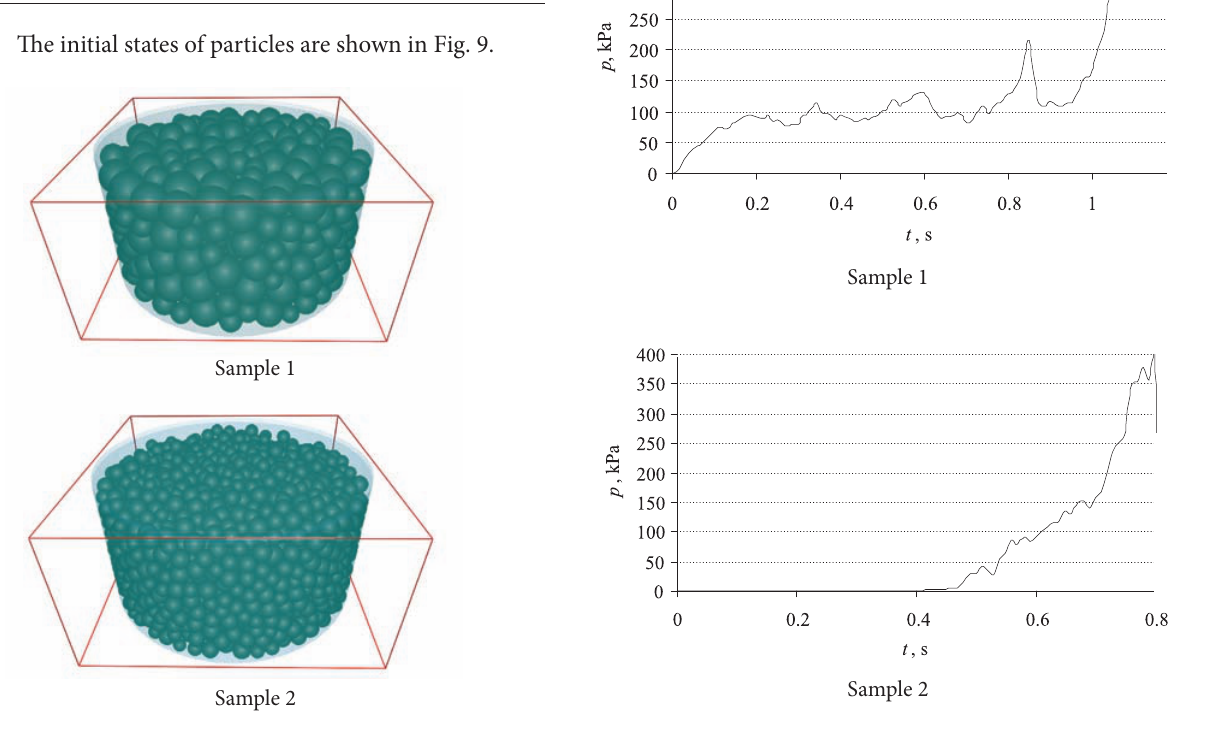
Fig. 9. Initial state of tested specimens Fig. 10. Loading histories p ( t